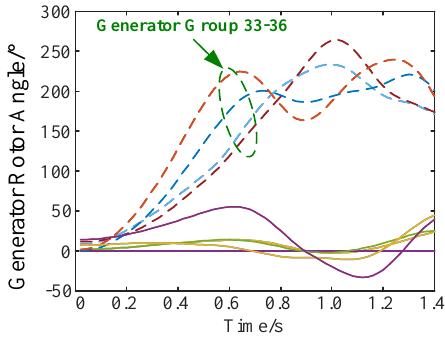
Figure 9. Variation of the generator rotor angles (strategy 1).